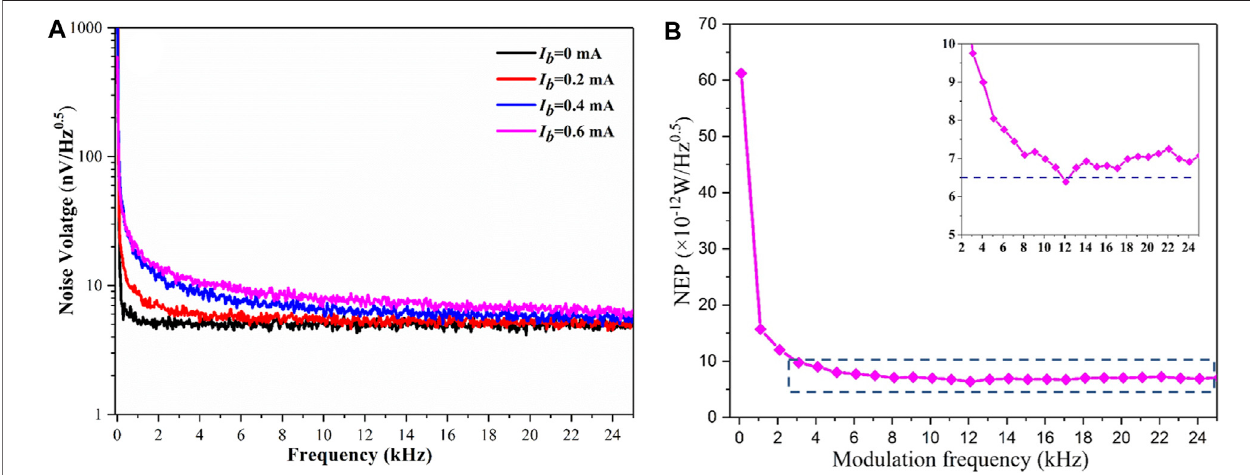
FIGURE 7 | (A) Measured noise voltage under different bias currents and (B) the calculated NEP as a function of the modulation frequency for the Nb 5 N 6 THz detector.